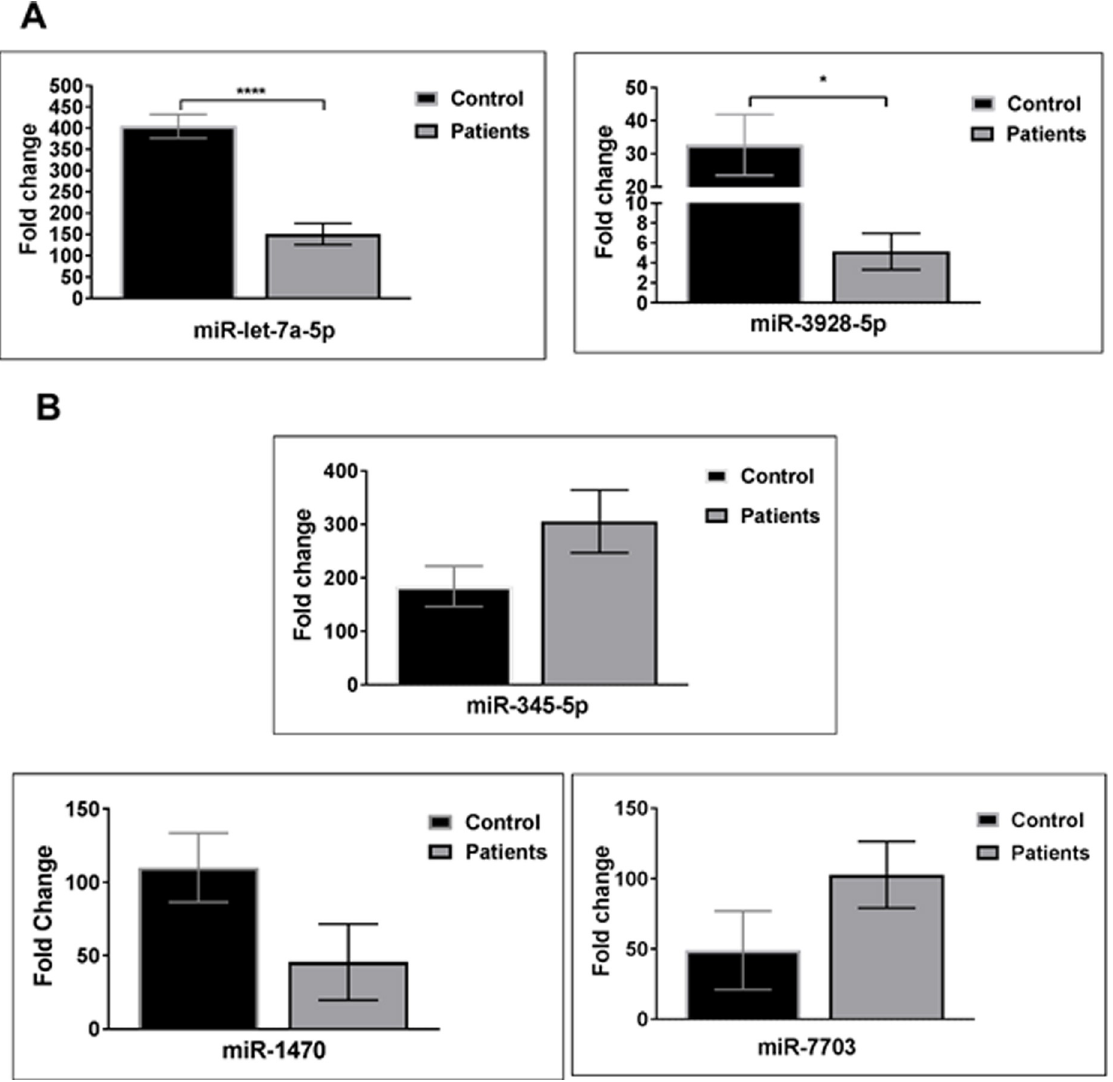
Fig 1. Expression of candidate miRNA in supernatant saliva of subjects (n = 150) vs. control (n = 80). (A) Significant decrease of miR- let-7a-5p, miR-3928. (B) Expression of miR-345-5p, miR-1470 and miR-7703, p-values is indicated as follows: � p < 0.05 and ���� p < 0.001 (t